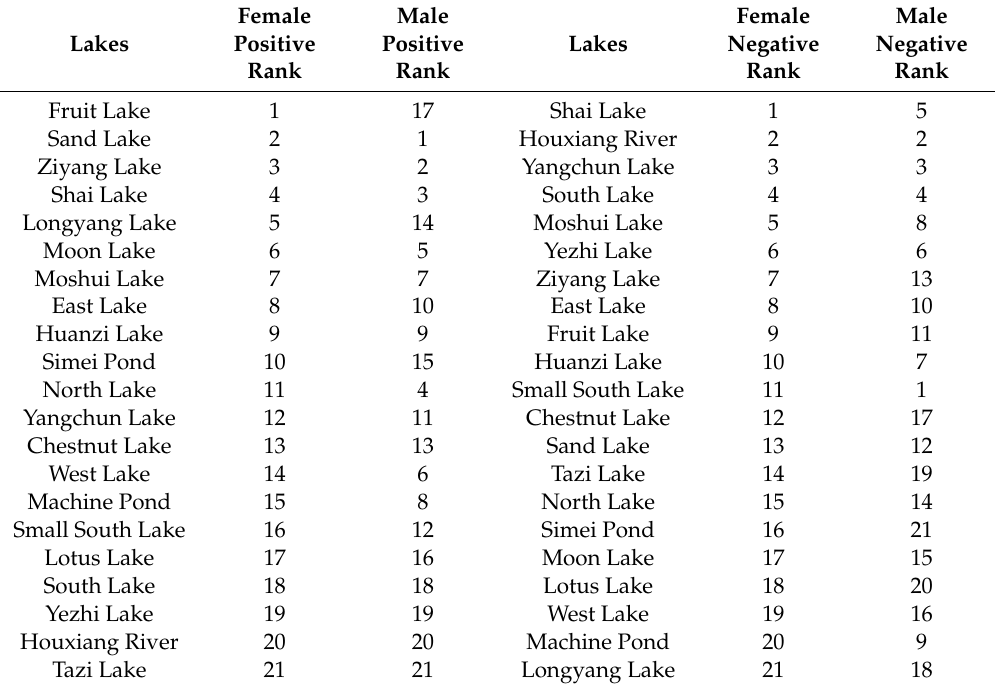
Table 4. Emotional score ranking of each